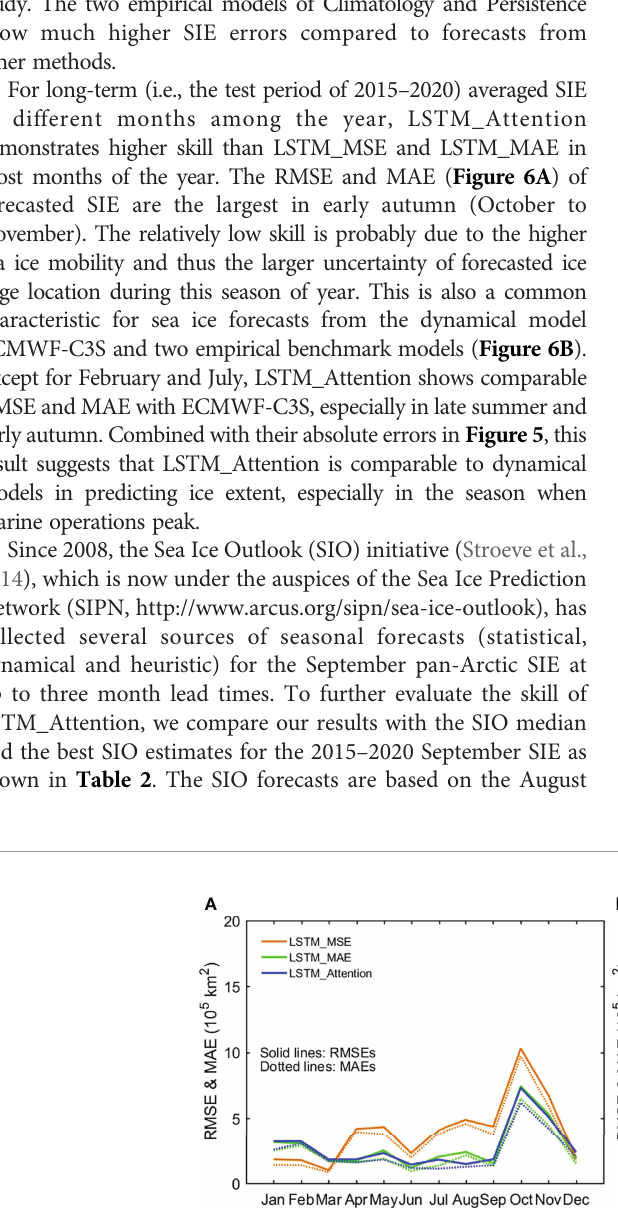
FIGURE 6 | RMSEs (solid lines) and MAEs (dotted lines) of forecasted monthly SIE in 2015 – 2020 using three LSTM models (A) and using LSTM_Attention, ECMWF-C3S, and two empirical models (B) . In both (A, B) , the lead time is one month.